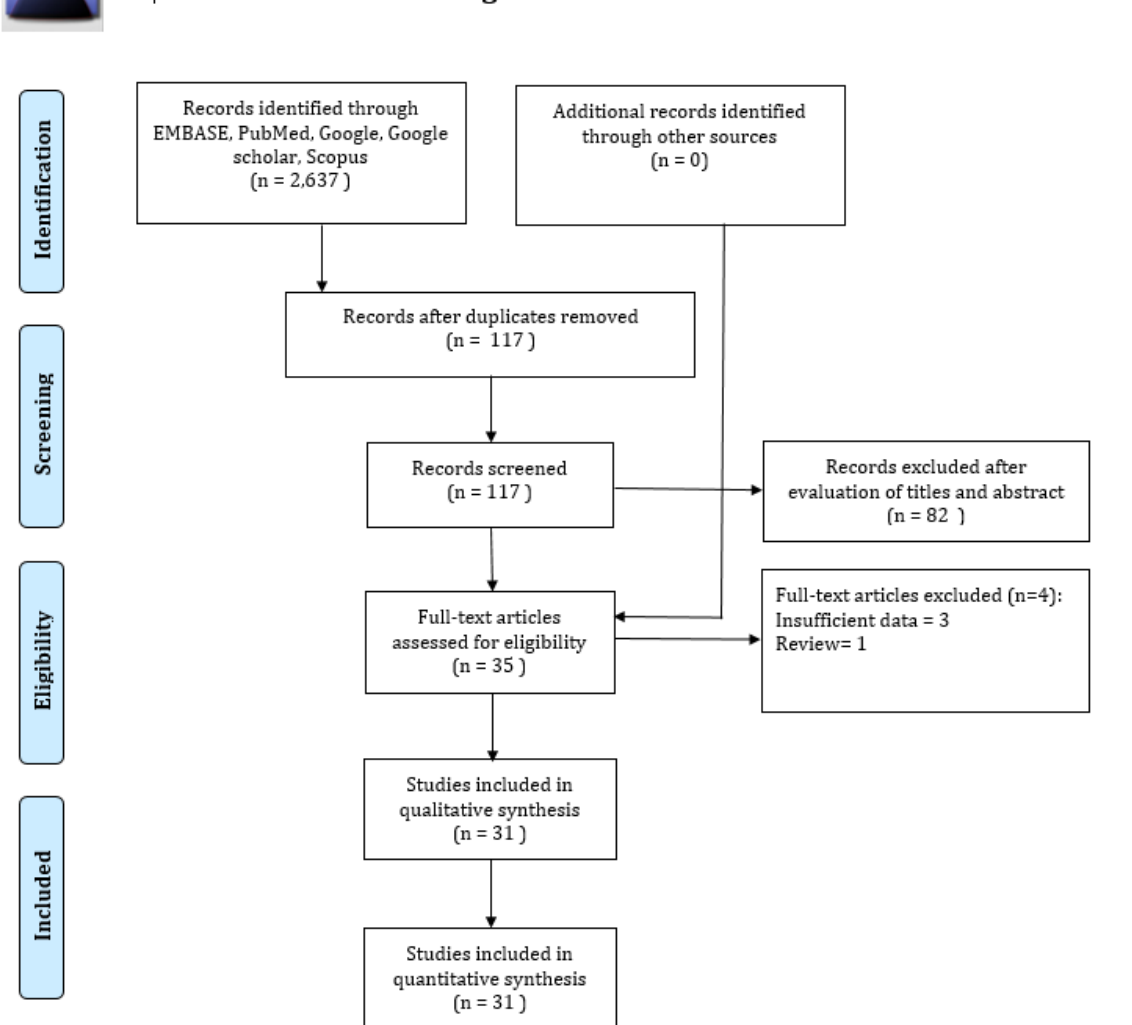
Figure 6. PRISMA (Preferred Reporting Items for Systematic Reviews and Meta-Analyses) flow diagram for study selection.